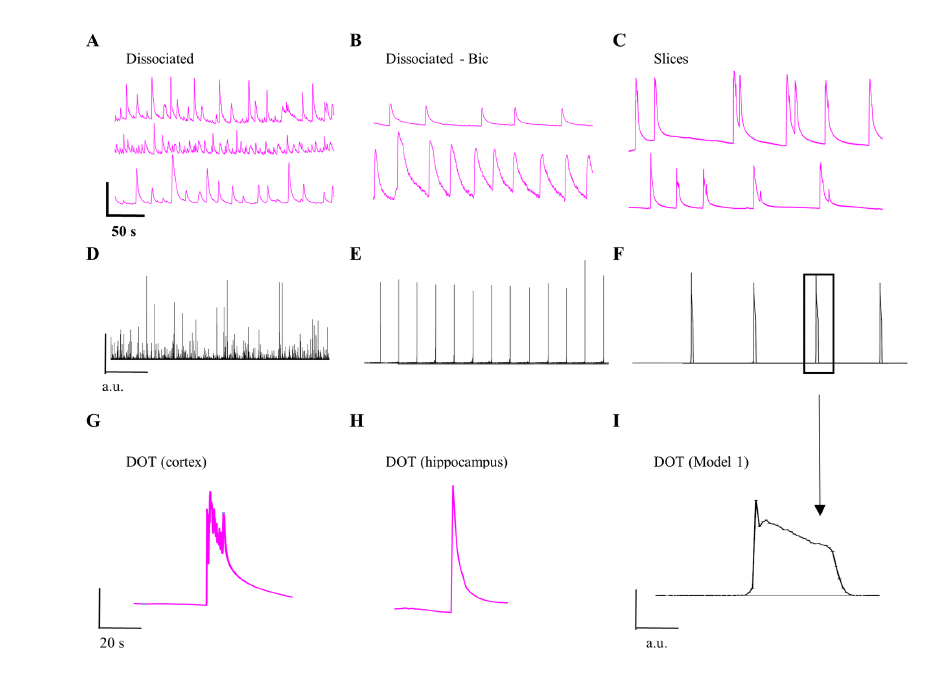
Fig. 8. Intermittency in dissociated and native networks and corresponding simulations. Experimental results are shown in purple, while time series obtained from the simulations are shown in black. (A) ΔF/F network in dissociated MD/HD cultures. (B) ΔF/F network in dissociated MD/HD cultures after application of Bicuculline 1 µM. (C) ΔF/F network in some representative cortical slices. Scale bar, 0.1 ΔF/F network . (D) Time series of a single-layer network from Model1. (E) Time series from the same simulated network after decreasing λ. (F) Time series from a multilayer network from Model1. In these plots, the x-axis are in units of number of perturbations, i.e., simulation time steps Δτ (arbitrary units, a.u.). In the multilayer model, a Δτ of 50,000 perturbation steps have been used. (G, H) Enlarged DOTs from ΔF/F network of experimental recordings in cortical and hippocampal slices, respectively. Scale bar, 0.1 ΔF/F network . (I) Enlarged DOT from the simulation of the multilayer